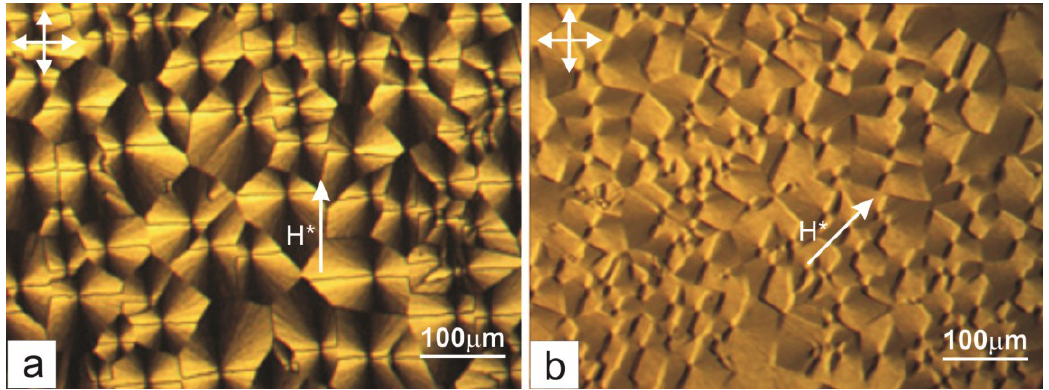
Figure 11. Microphotographs of the 5CB structure on the PC substrate parallel to which magnetic field H * was applied during the domain growth. ( a ) Direction of field H * coincides with the direction of one of the microscope polarizers (the polarizer axes are indicated by arrows); and ( b ) the direction of field H * makes an angle of 45° with the polarizer